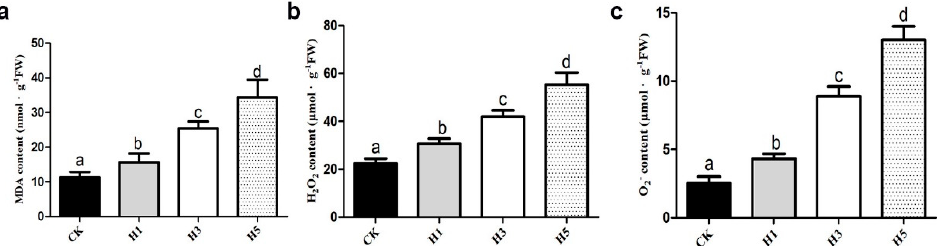
Figure 2. Determination of oxidizing substance content. ( a ) MDA content, ( b ) H 2 O 2 content, ( c ) O 2 content. CK, control group; H1, group with heat stress treatment for 1 d; H3, group with heat stress treatment for 3 d; H5, group with heat stress treatment for 5 d.